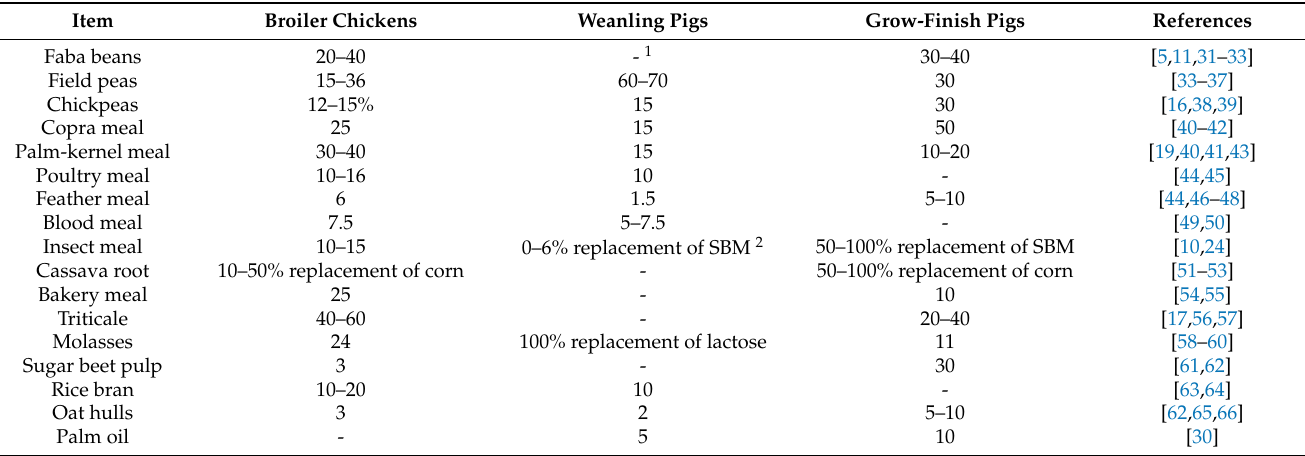
Table 2. Recommended inclusion rate (%) in diets of pigs and broiler